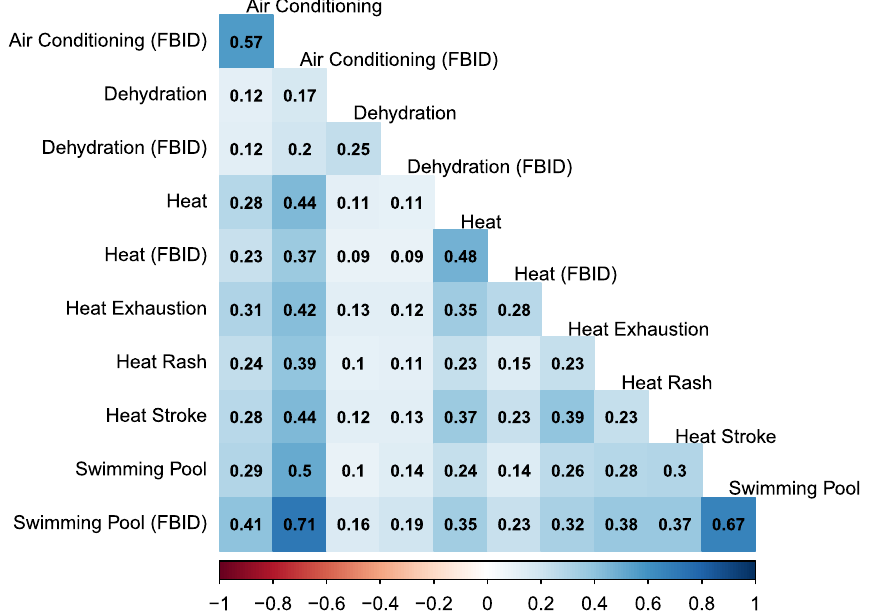
Figure 3. Median Spearman Correlation coefficients between Google search terms among 30 DMAs.